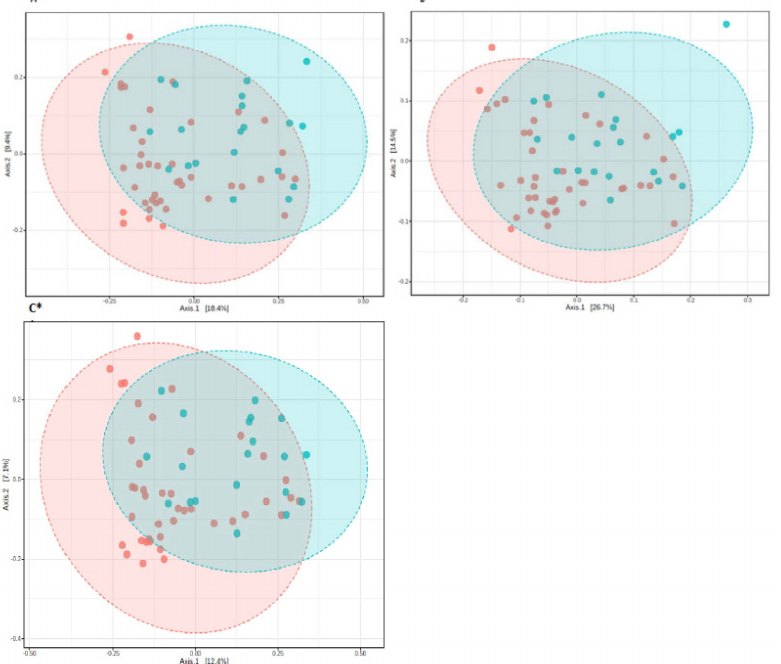
Figure 2. Principal coordinate analysis (PCoA) plots of individual fecal microbiota based on Bray- Curtis ( A ), Jensen-Shannon Divergence ( B ), Jaccard Index ( C ). Red dots represent controls, while blue ones represent PD patients. The symbol * represents the statistical significance * p <